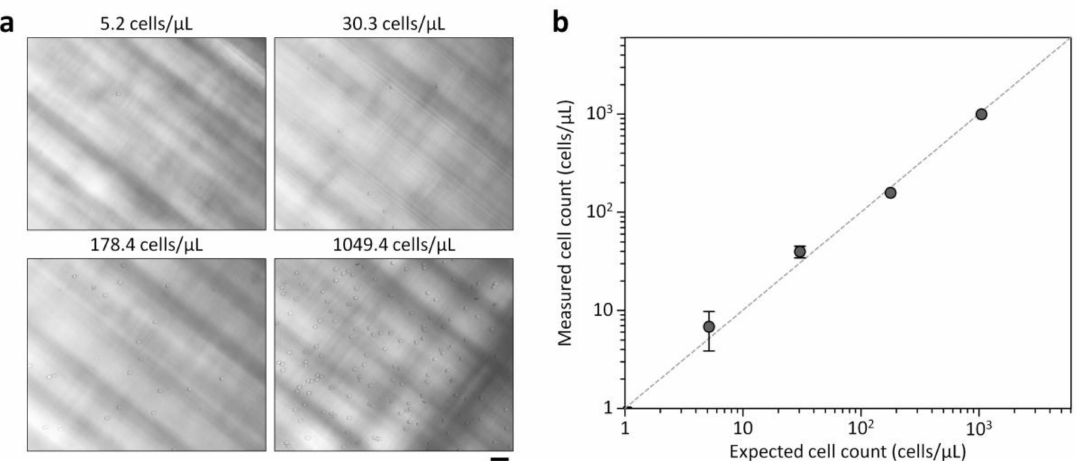
Figure 5. RBC counts measured with the cell counting platform and estimated with a standard hemocytometer. ( a ) Bright-field images of RBCs in the counting chamber at different cell concentrations. Scale bar, 50 µ m. ( b ) On-chip RBC counts versus expected RBC counts from the hemocytometer, with the dotted line representing the unity slope. Error bars: s.d. ( n =